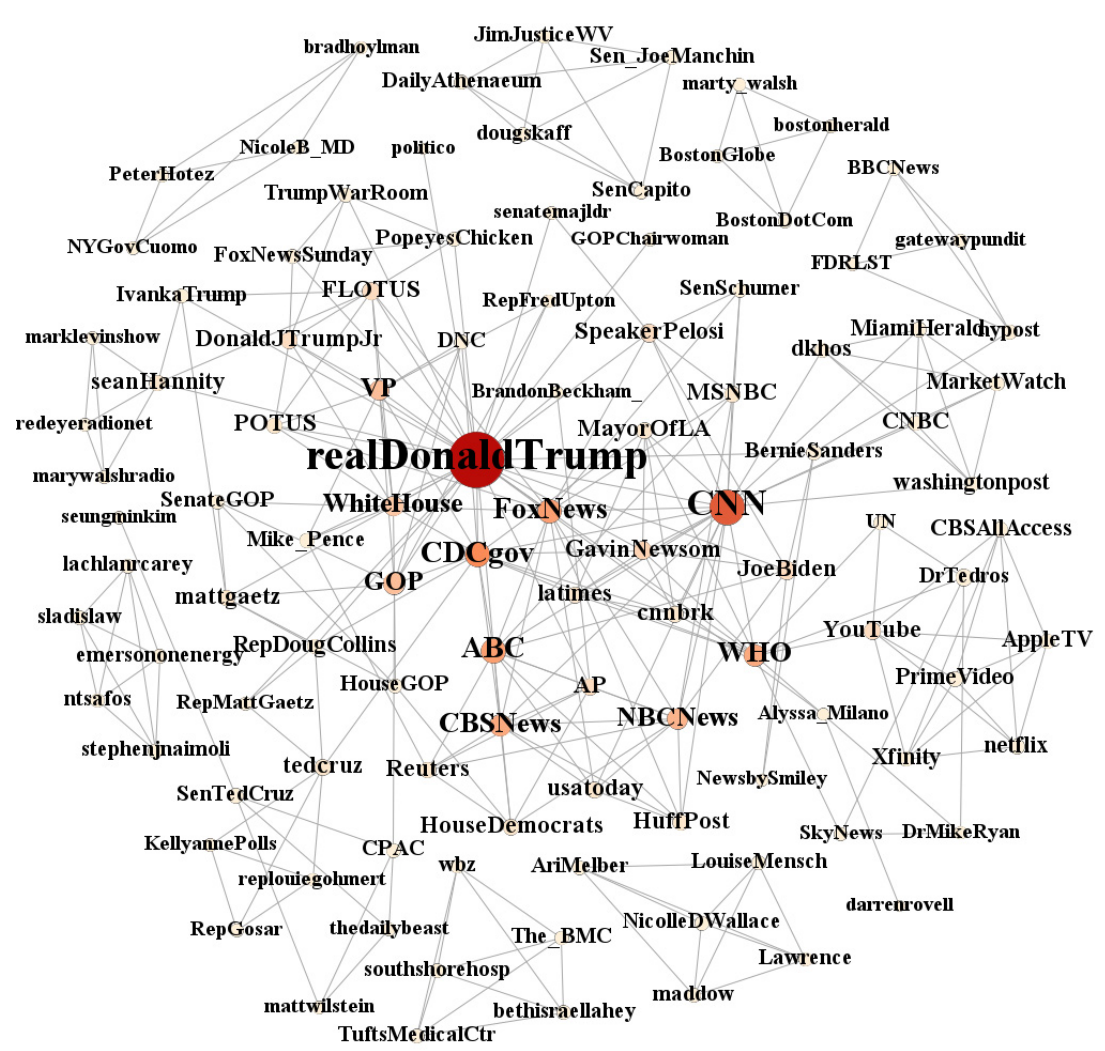
Figure 4. Whole network of